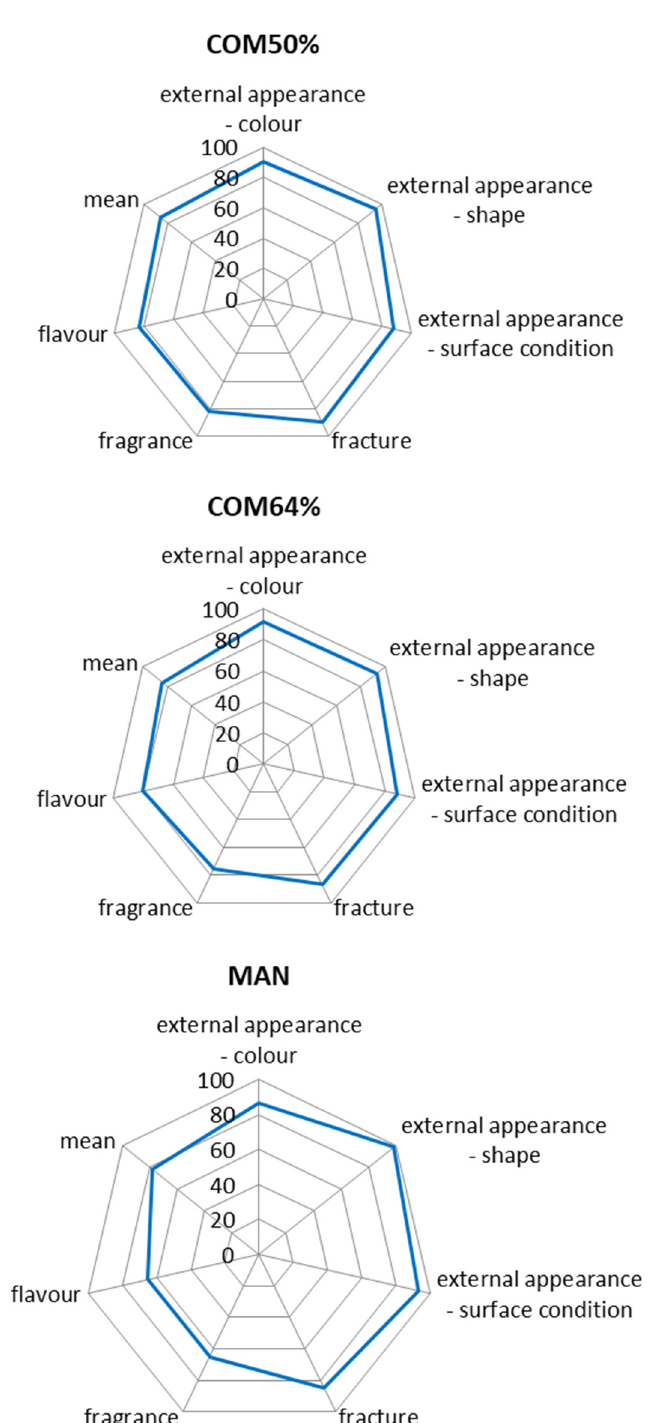
Figure 6. Results of five-point evaluation of the chocolates. MAN—raw chocolate, COM 64%—clas- sic bitter chocolate 64%, COM 50%—light bitter chocolate 50% (COM 50%). bitter chocolate 64%, COM 50%—light bitter chocolate 50% (COM